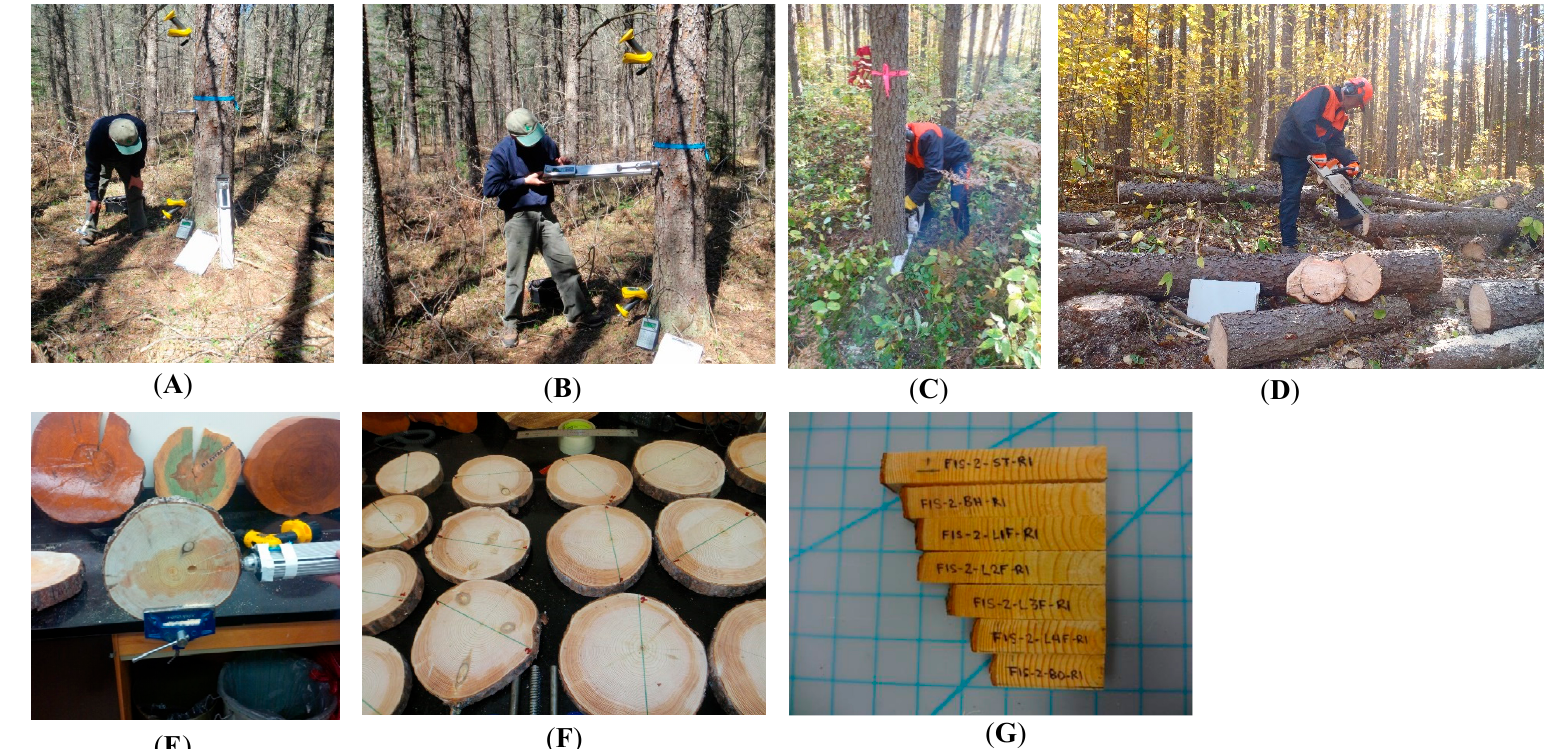
Figure 1. Sequential pictorial exemplification of in-forest and in-lab data acquisition procedures preceding wood attribute determination via Silviscan-3 and subsequent statistical analytics: ( A ) acoustic sampling of standing jack pine tree with Director ST-300 time-of-flight instrument with yellow probes and hammer impact action shown (i.e., generating and measuring the dilatational stress wave). ( B ) Resistograph micro-drill sampling at breast-height, ( C ) felling a sample tree, ( D ) destructive stem analysis on a delimbed and topped tree and extraction of cross-sectional disk samples, ( E ) in-lab extraction of resistance profiles via the Resistograph (e.g., from bark to artificially created circular-shaped void). ( F ) Demarcation of the geometric mean diameter on each cross-sectional disk, and ( G ) extracted and random selected 2 × 2 cm pith-to-bark radial sequences from one sample tree (e.g., seven labelled sequences extracted from the stump height (-ST-) and breast-height (-BH-) cross-sectional disks, and those at relative heights of 10% (-L1F-), 30% (-L2F-), 50% (-L3F-), 70% (-L4F-), and 80% (-80-)).